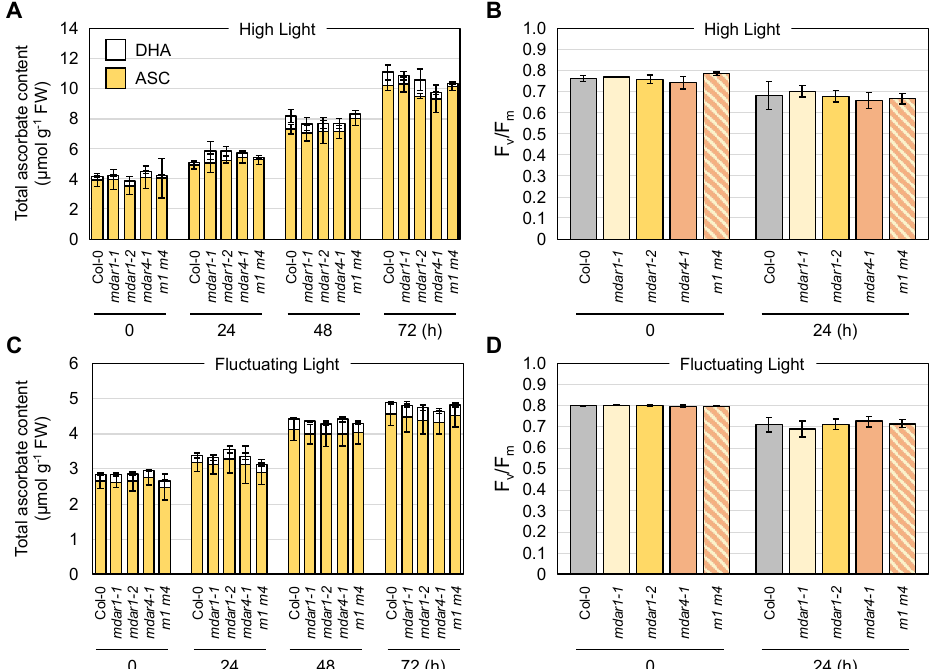
Figure 8. The impacts of AthMDAR1 and 4 on the foliar ascorbate profile under light stress conditions. Arabidopsis thaliana wild-type (Col-0), mdar1-1 , mdar1-2 , mdar4-5 , and mdar1-1 mdar4-5 ( m1 m4 ) plants were first grown on half-strength MS medium containing 1% sucrose for 1 week. This was because the loss-of-function of AthMDAR4 results in a seedling-lethal phenotype in the absence of exogenous sugar application. Plants were then transferred to soil and grown for a further 3 weeks. Four-week-old plants grown under normal light (100 µmol photons m −2 s −1 ) conditions were exposed to ( A , B ) high light (1500 µmol photons m −2 s −1 ) or ( C , D ) fluctuating light (see Materials and Methods) for 72 h. ( A , C ) The total ascorbate content (the sum of the reduced and oxidized forms) in the leaves was measured. The ascorbate redox state (the ratio of the reduced form to the total content) is shown in Table S3. ( B , D ) The maximum quantum yield of photosystem II (F v /F m ) was measured before and after stress. Data are presented as the mean ± SE of at least three biological replicates. There were no significant differences in the ascorbate profiles and F v /F m values among the genotypes at any time (Tukey–Kramer test). ASC, reduced ascorbate; DHA, dehydroascorbate (oxidized form).